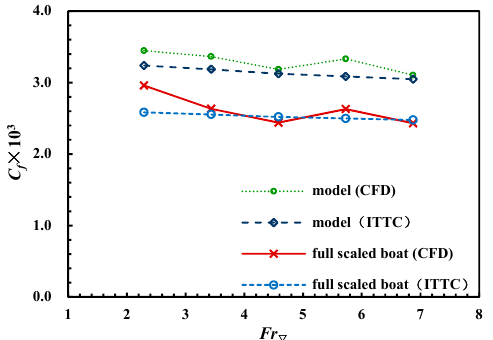
Figure 15. Fractional resistance coefficient from numerical simulation and 1957 ITTC method.